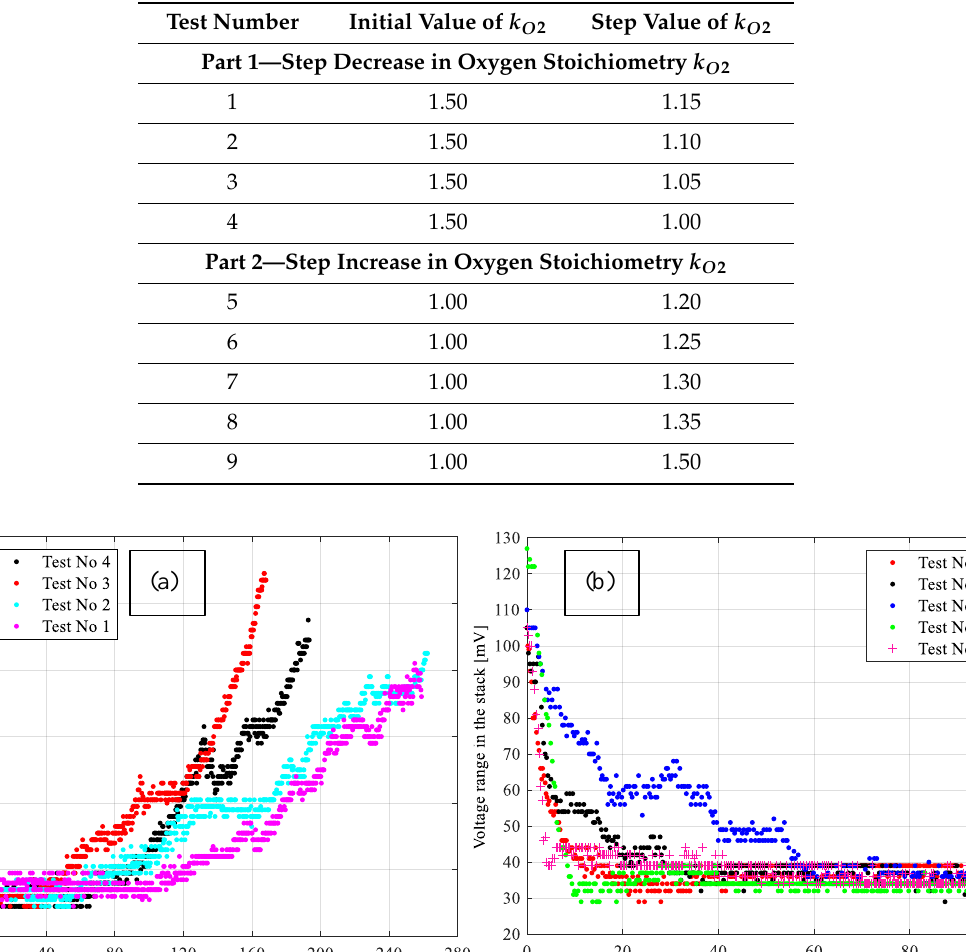
Table 2. Cathode stoichiometry changes during identification experiment.